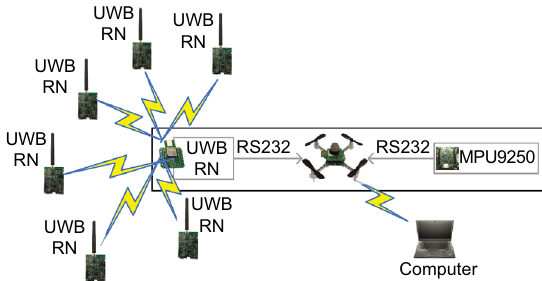
Fig. 5 The frame of the testbed